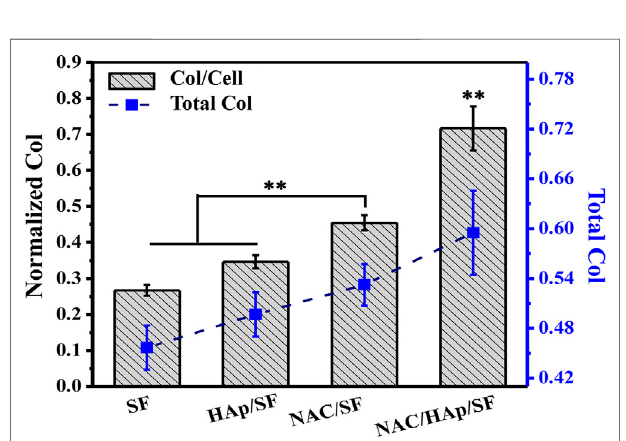
FIGURE 9 | Quantitative results of COL after 14 days of culture of iPSC- MSCs on different nano fi bers, n (cid:1) 3.